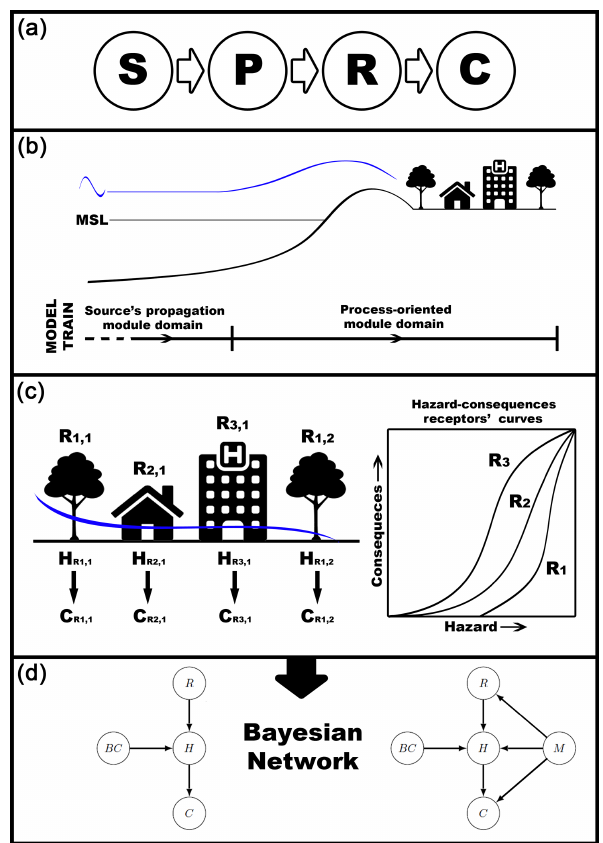
Figure 4. General methodology. (a) The SPRC conceptual frame- work is implemented through (b) a model chain, which consists of a propagation module of the source (S) and a process-oriented module for the coastal area reproducing the pathway (P). Then, (c) the con- sequences (C) are calculated based on the computed hazards (H) at the receptor (R) scale by using vulnerability relations (i.e. hazard– consequences functions). In the last step (d) , all variables including source boundary conditions (BC) are fitted in a BN, as well as im- pacts and the implementation of measures